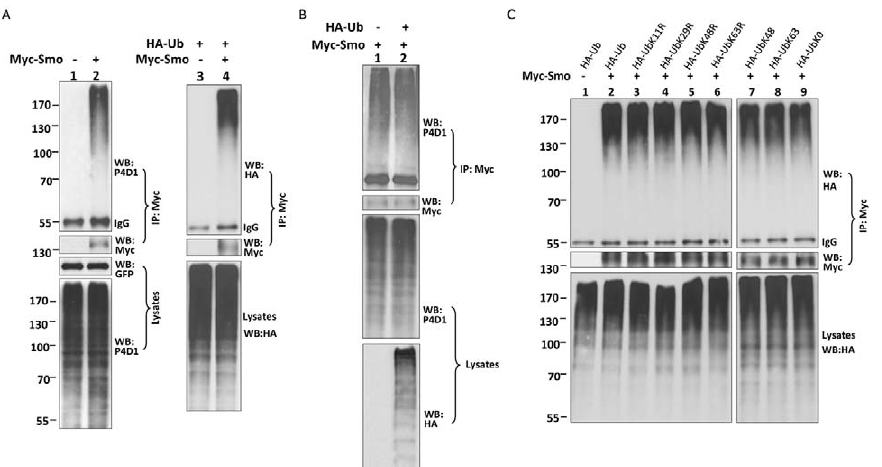
Figure 1. Multi-monoubiquitination of Smo in Drosophila S2 cells. (A) S2 cells were transfected with Myc-Smo alone or in combination with HA-Ub, followed by immunoprecipitation and Western blot analysis with the indicated antibodies. A blank vector was used as the immunoprecipitation control, GFP as the transfection control, and IgG as the loading control. (B) Myc-Smo was transfected in S2 cells with or without HA-Ub followed by immunoprecipitation and Western blot with the indicated antibodies. The expression of HA-Ub did not cause any changes in the levels of Smo ubiquitination. The levels of HA-Ub are comparable to the levels of free Ub detected by P4D1 (bottom panel). (C) Myc- Smo was co-transfected with HA-Ub or with each individual HA-tagged Ub mutant, followed by immunoprecipitation and Western blot analysis. HA- Ub and Ub mutants gave rise to a similar smear pattern (top panel).